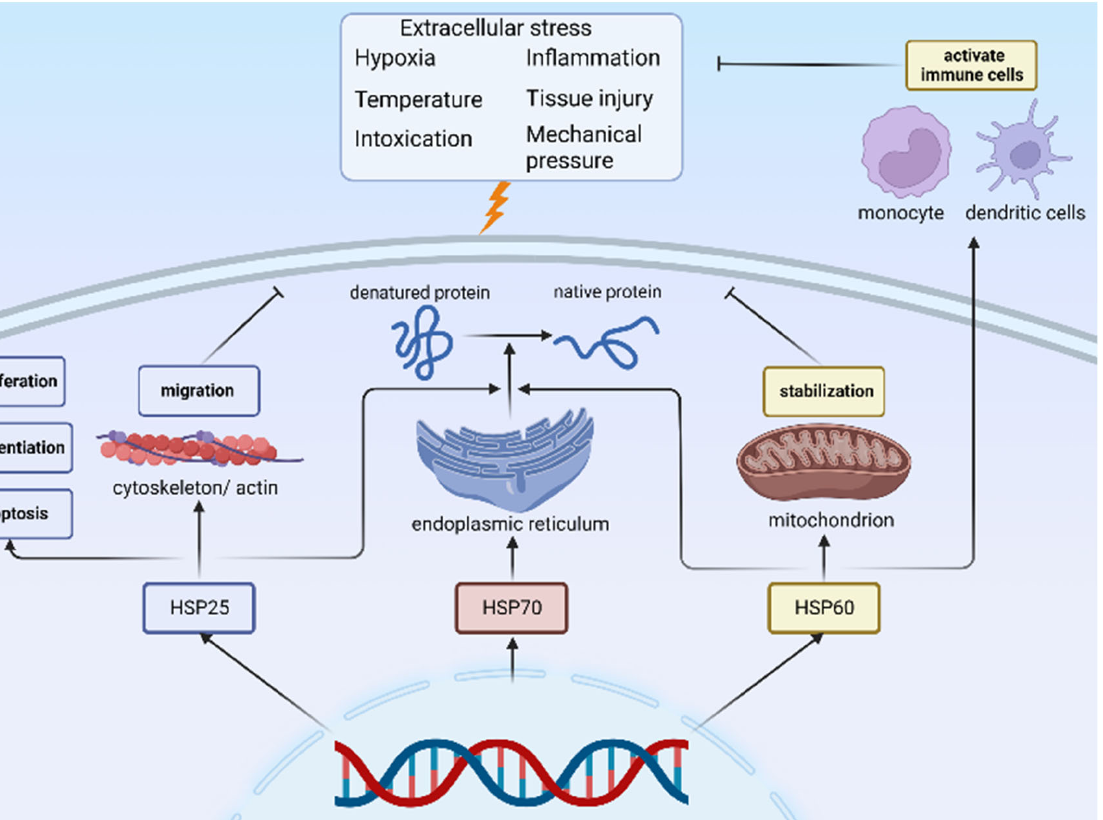
Figure 1. HSPs help cells resist external stimuli and maintain cell stability in different ways when cells encounter external stimuli. In addition, HSPs are also an important member of maintaining normal cell activity in healthy conditions. ( ⊥ ): inhibit. Figures created with BioRender.com, accessed on 19 September 2022.